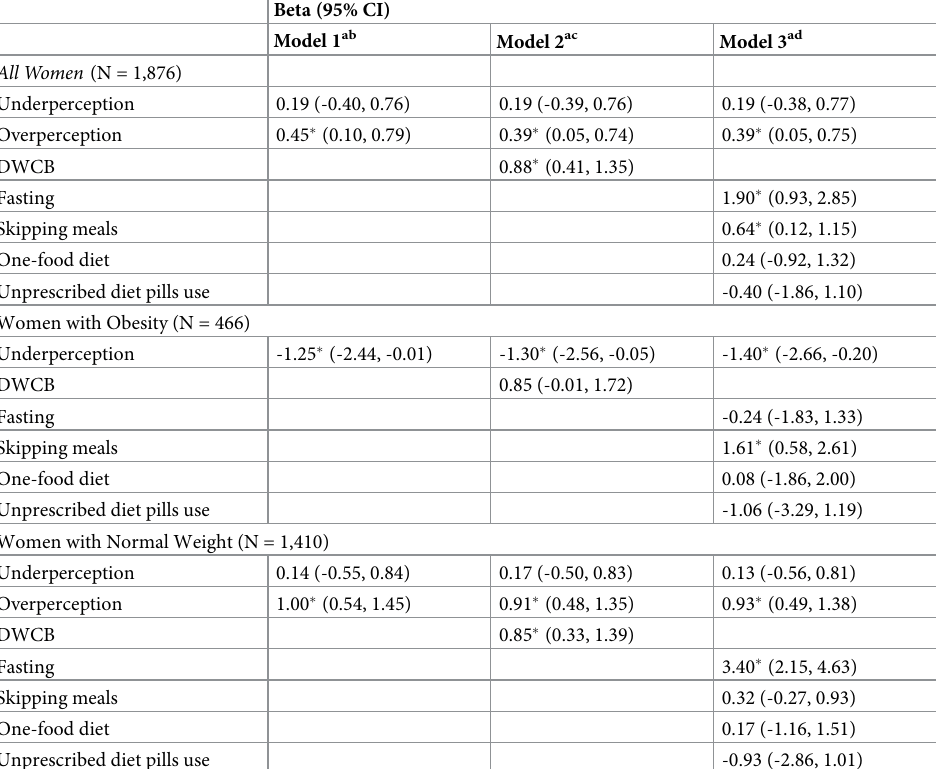
Table 2. Association of weight status perception pattern and disordered weight control behaviors with depressive symptoms (PHQ-9K) among Korean women (N = 1,876) aged 19–65 years with BMI > = 18.5kg/m 2 and no history of